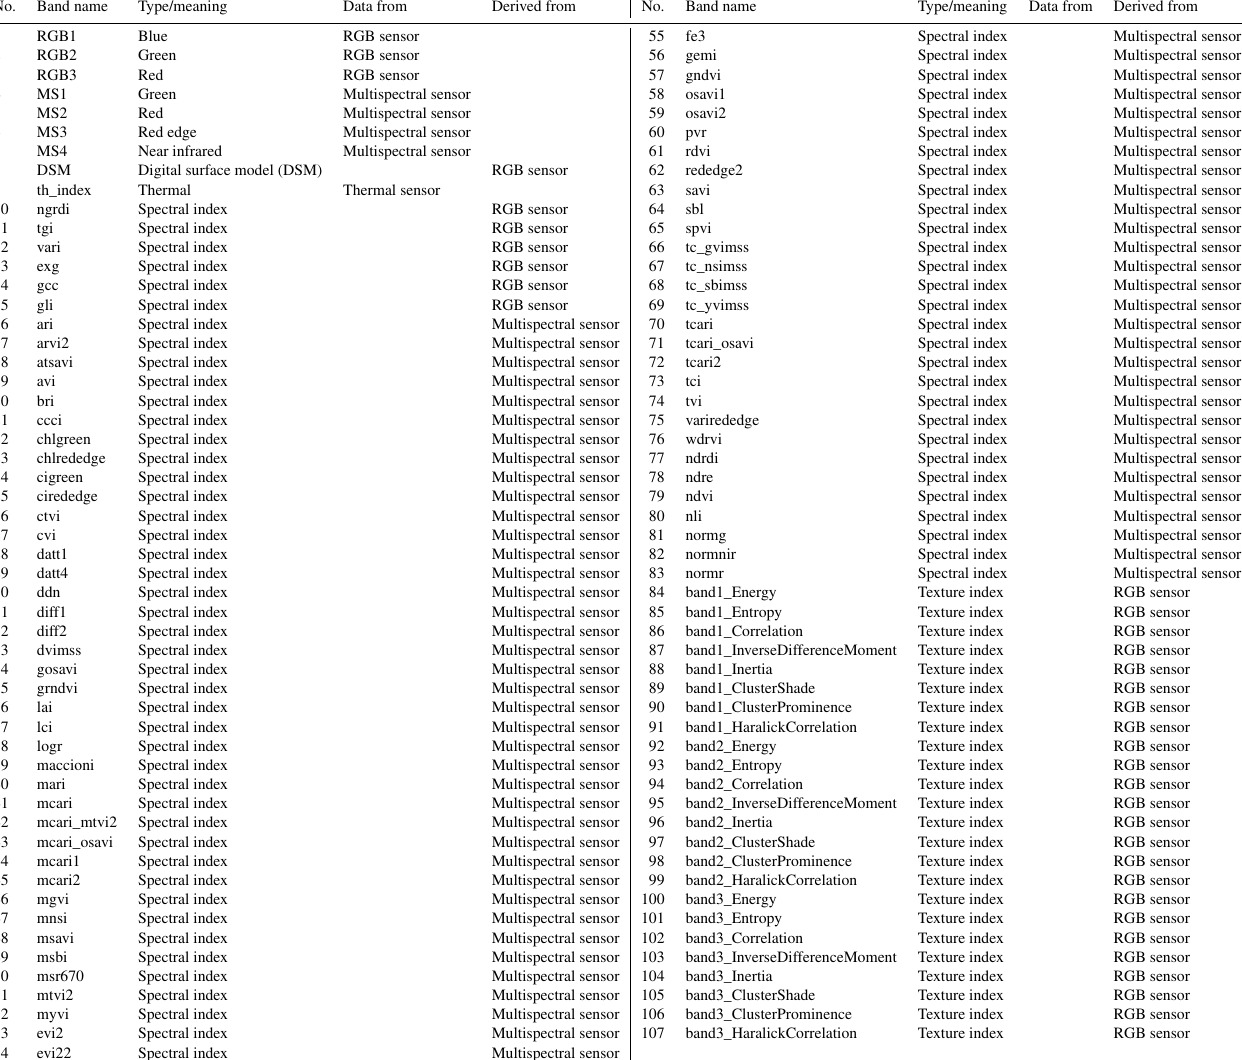
Table C1. Multisensor data set consists of 107 bands. All indices are described in https://github.com/florianbeyer/SpectralIndices, last access: 24 January